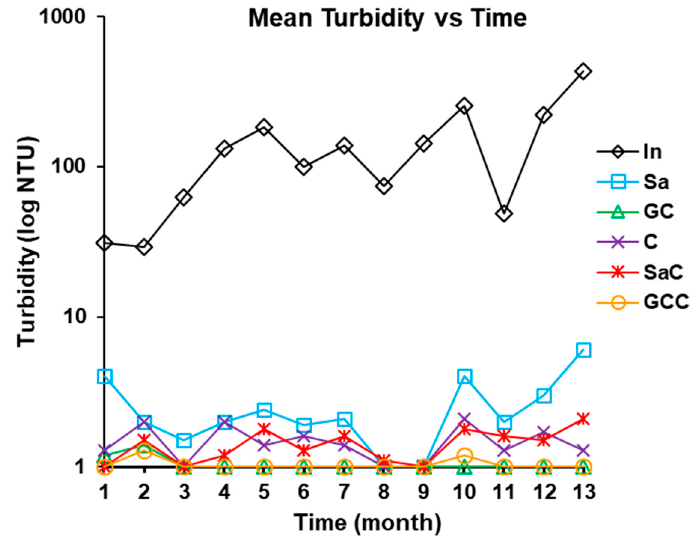
Figure 3. Mean influent and effluent turbidity trend during the entire study (In, inlet; Sa, sand; GC, gas concrete; C, biochar; SaC, sand + biochar; GCC, gas concrete + biochar).